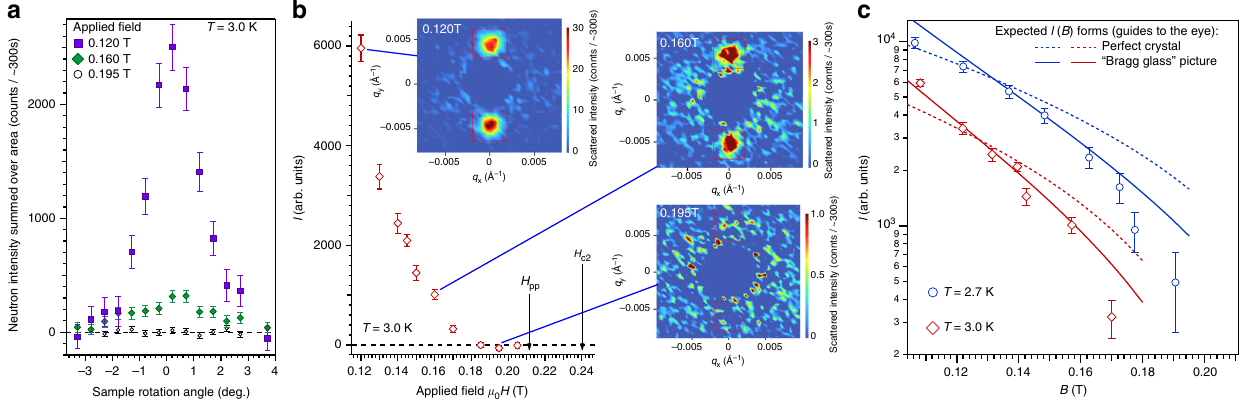
Sample rotation angle (deg.) Fig. 5 Field dependence of neutron scattering at higher temperatures. Field-cooled vortex ensembles are probed in perpendicular fi eld geometry (Fig. 2b) with horizontal applied fi eld. Backgrounds measured at zero fi eld are subtracted. a Rocking curves at 3.0 K showing counts summed over an area on the 2D multidetector encompassing the top Bragg spot. Error bars are determined by Poisson statistics. b Top and bottom Bragg spot rocking curves are integrated numerically and the sum I plotted versus applied fi eld. I vanishes much before the peak effect fi eld H pp anticipated from the phase diagram (Fig. 1). Each 2D image shows the SANS multidetector averaged over the rocking scan. Noise from subtraction at the centre of each image is masked. Red boxes indicate areas summed in the rocking curves. c Semilogarithmic plots at 2.7 and 3.0 K of I versus fl ux density B calculated from observed Bragg spot position g using (cid:3) 1 = 2 for a triangular lattice. Dotted lines are guides to the eye illustrating I ( B ) forms expected if vortices were arranged in perfect 2D lattices. Solid lines are guides to the eye showing the steeper descents expected in the Bragg glass picture